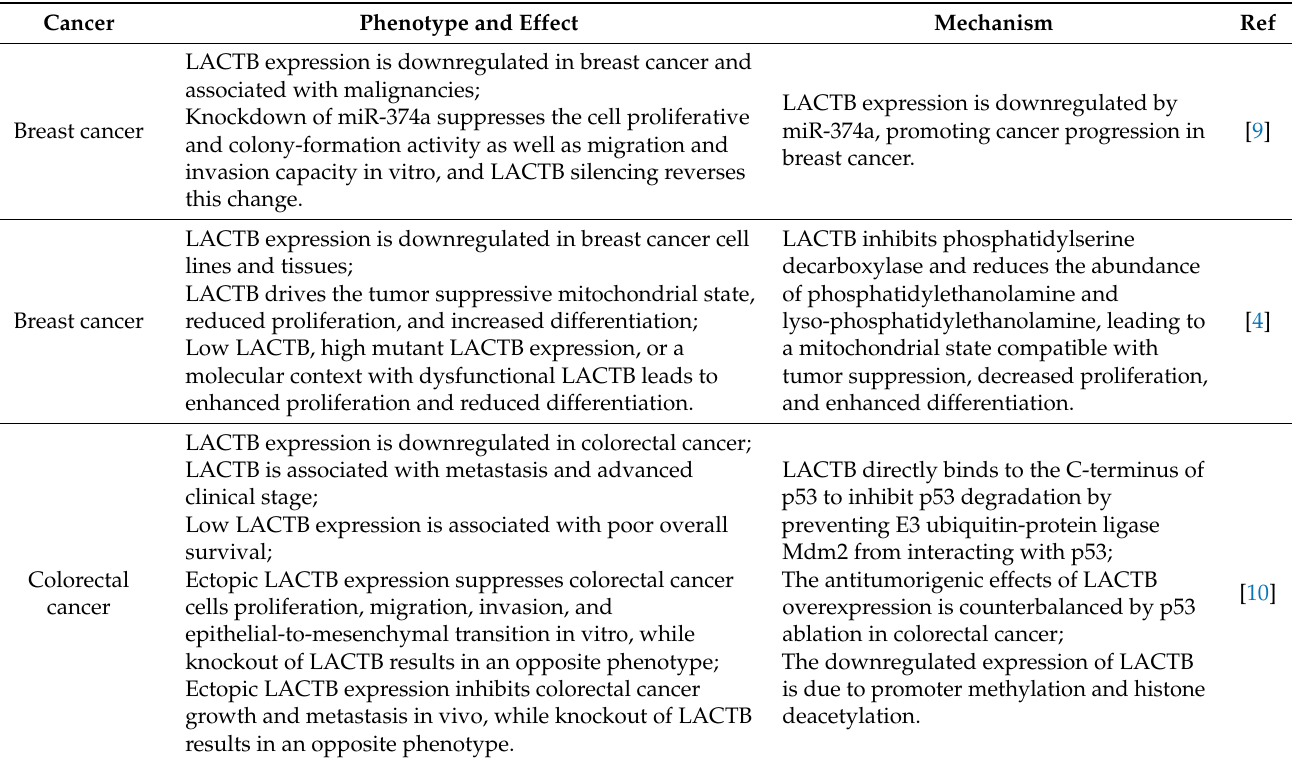
Table 1. The roles of LACTB in cancers and related